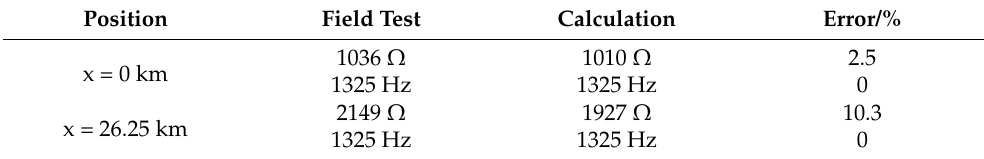
Figure 6. ( a ) Schematic of the two tests in the actual railway; ( b ) comparison and error analysis between the calculation and the field test at x = 0 km; ( c ) comparison and error analysis between the calculation and the field test at x = 26.25 km. Table 2. Absolute value of the impedance error percentage of the field test and